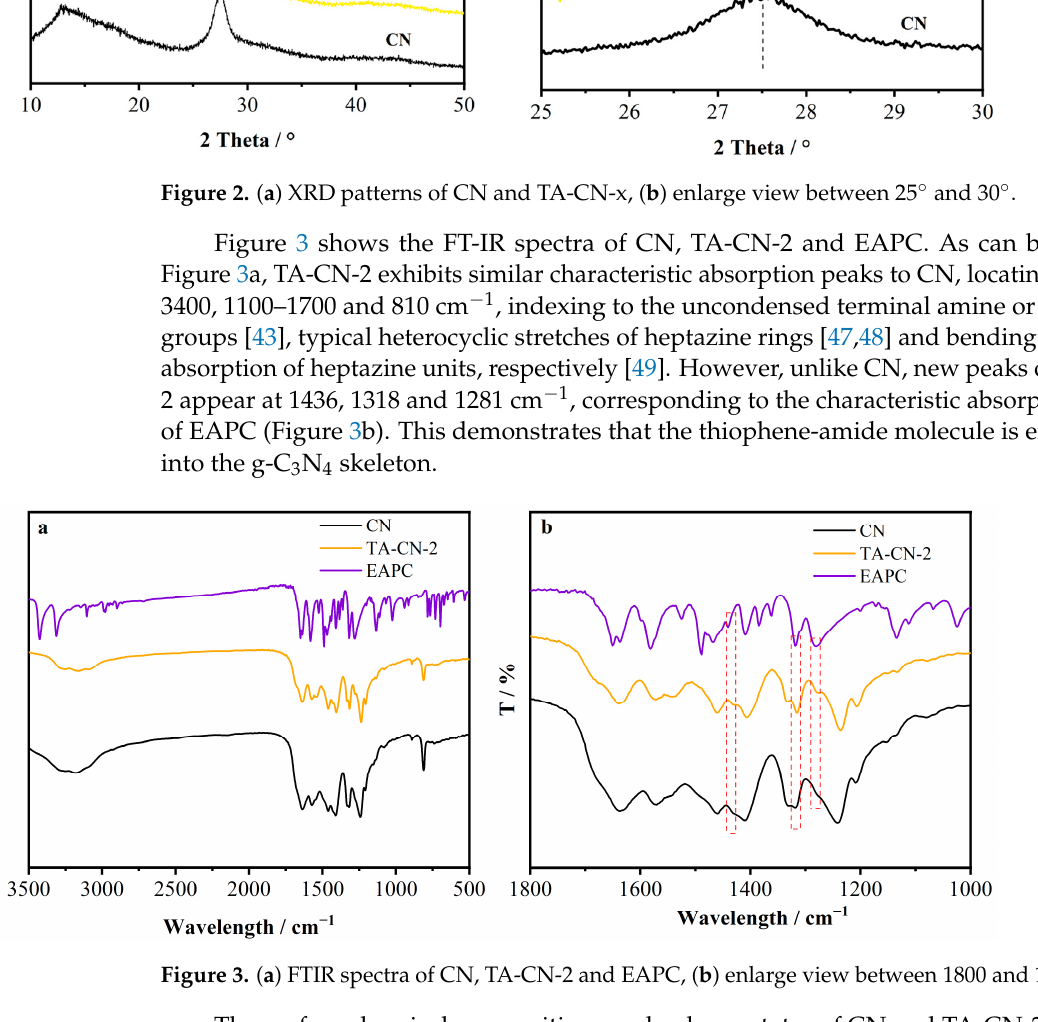
Figure 4. High-resolution XPS spectra of ( a ) C 1s, ( b ) N 1s, ( c ) O 1s of CN and TA-CN-2. ( d ) High- resolution XPS spectrum of S 2p of TA-CN-2.